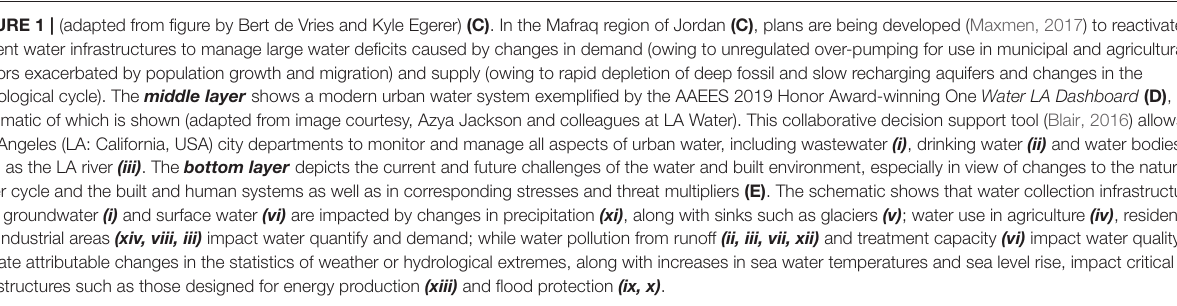
FIGURE 1 | (adapted from figure by Bert de Vries and Kyle Egerer) (C) . In the Mafraq region of Jordan (C) , plans are being developed (Maxmen, 2017) to reactivate ancient water infrastructures to manage large water deficits caused by changes in demand (owing to unregulated over-pumping for use in municipal and agricultural sectors exacerbated by population growth and migration) and supply (owing to rapid depletion of deep fossil and slow recharging aquifers and changes in the hydrological cycle). The middle layer shows a modern urban water system exemplified by the AAEES 2019 Honor Award-winning One Water LA Dashboard (D) , a schematic of which is shown (adapted from image courtesy, Azya Jackson and colleagues at LA Water). This collaborative decision support tool (Blair, 2016) allows Los Angeles (LA: California, USA) city departments to monitor and manage all aspects of urban water, including wastewater (i) , drinking water (ii) and water bodies such as the LA river (iii) . The bottom layer depicts the current and future challenges of the water and built environment, especially in view of changes to the natural water cycle and the built and human systems as well as in corresponding stresses and threat multipliers (E) . The schematic shows that water collection infrastructure from groundwater (i) and surface water (vi) are impacted by changes in precipitation (xi) , along with sinks such as glaciers (v) ; water use in agriculture (iv) , residential and industrial areas (xiv, viii, iii) impact water quantify and demand; while water pollution from runoff (ii, iii, vii, xii) and treatment capacity (vi) impact water quality. Climate attributable changes in the statistics of weather or hydrological extremes, along with increases in sea water temperatures and sea level rise, impact critical infrastructures such as those designed for energy production (xiii) and flood protection (ix, x)